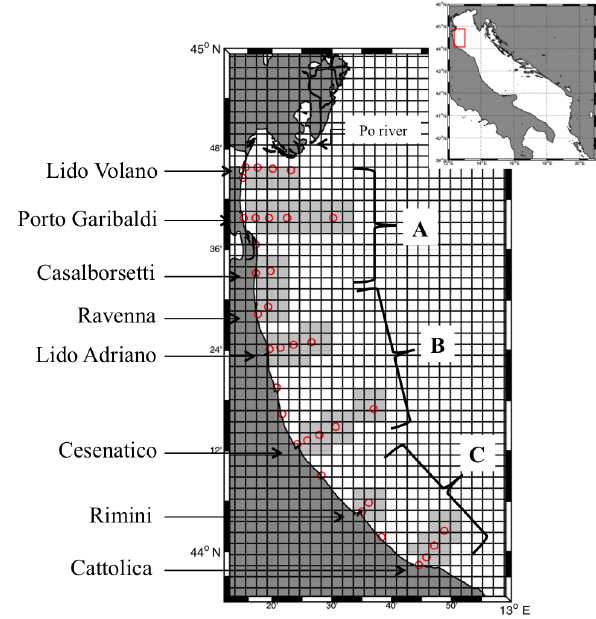
Figure 1. Emilia-Romagna coastal and shelf region monitored by ARPAE-Daphne: 21 stations, organized along eight transects (Lido Volano, Porto Garibaldi, Casalborsetti, Ravenna, Lido Adriano, Ce- senatico, Rimini, and Cattolica) from 500m to 10km distance from the coast. The Porto Garibaldi and Cesenatico transects enclose also two stations situated 20km offshore. The study area is divided into three areas (A, B, and C) based on hydrological and trophic con- ditions. The grey shaded areas indicate the model grid points from which model data were extracted to carry out the model